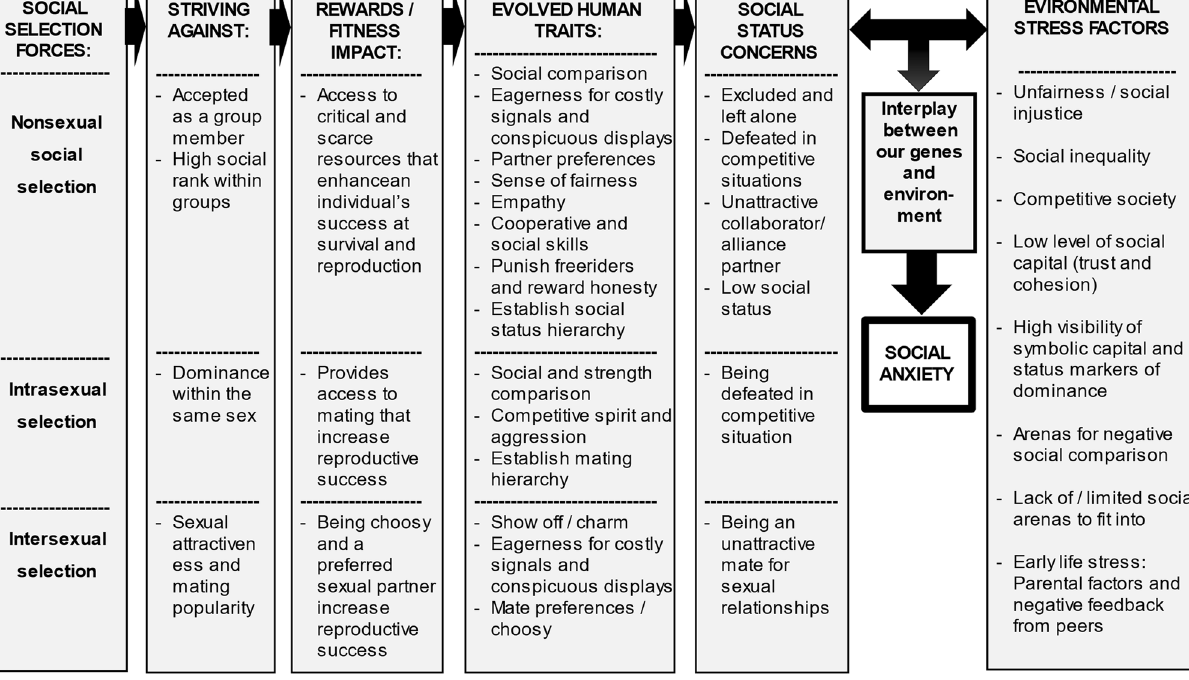
Fig. 2 A evolution-theoretical perspective of why humans are predisposed to social anxiety, and socioeconomic and sociocultural condi- tions that may enhance people’s propensity to develop social